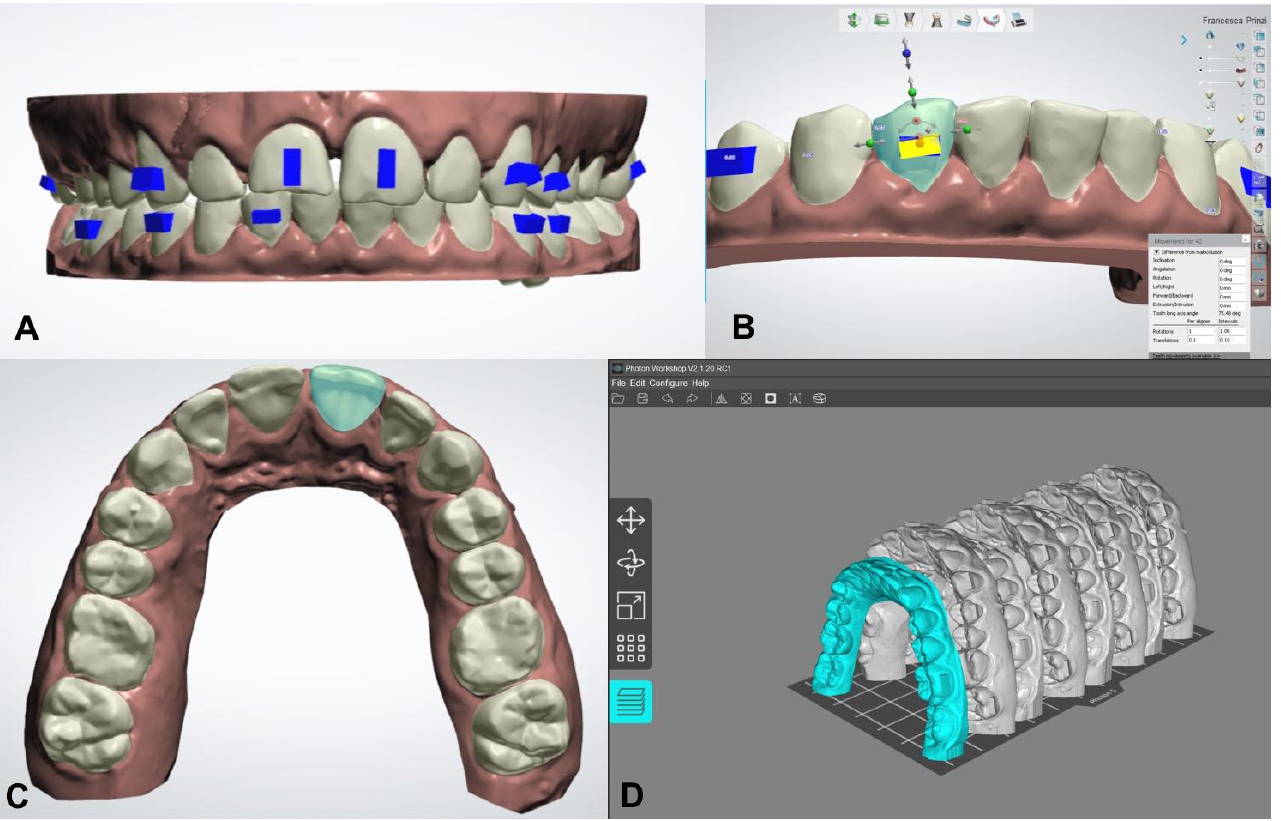
Figure 18. Example of digital workflow for the production of occlusal splint. ( A – C ), Digital setup using Ortho Analyzer software (3Shape, Copenhagen, Denmark); ( D ), models sequence ready for 3D printing using low-budget 3D printer (Photon S—Anycubic Technology Co., Shenzhen, China).